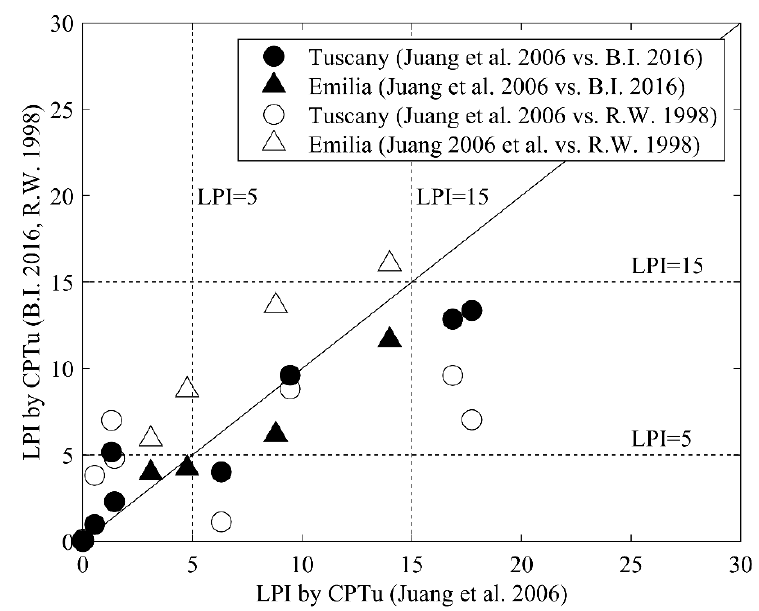
Figure 9. Comparison between the values of the Liquefaction Potential Index (LPI) obtained with CPTu by using all the considered liquefaction evaluation procedures (LEPs). B.I. = Boulanger and Idriss; R.W. = Robertson and Wride.